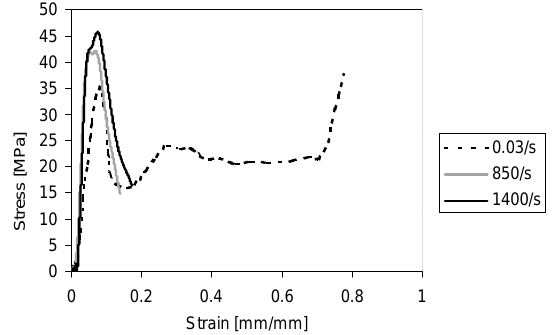
Fig.11. Out-of-plane stress-strain curves for CR-III Aluminum Hon-